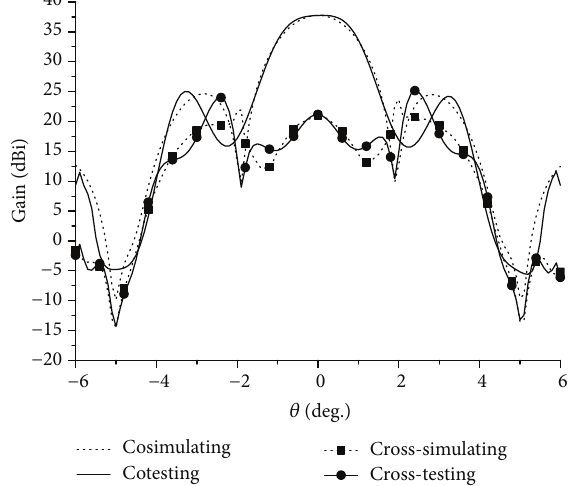
Figure 9: Simulating and testing radiation pattern in 𝜑 = 45 ∘ plane.